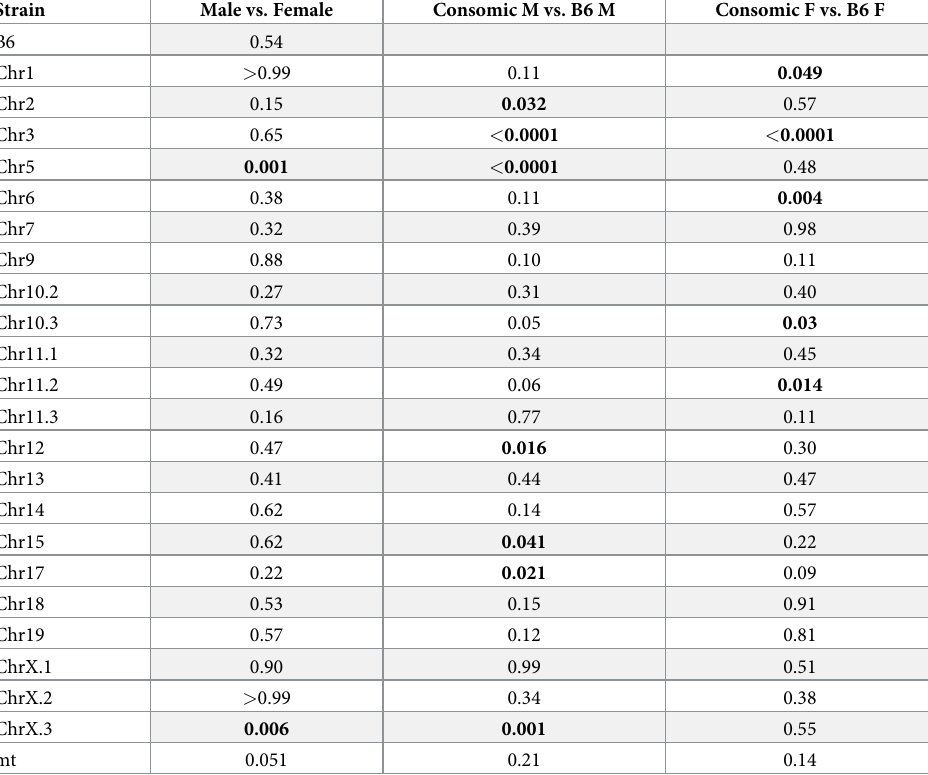
Table 2. Survival analysis of IAV-challenged consomic strains using sex-stratified data. Male and female consomic mice were challenged with IAV as described in Fig 3 . Significance of differences in survival assessed using the Mantel- Cox test and the P value are reported, with P < 0.05 shown in bold font. The following three comparisons were made: male vs. females of each consomic strain (Male vs. Female, column 1), consomic males vs. B6 males (Consomic M vs. B6 M, column 2), and consomic females vs. B6 females (Consomic F vs. B6 F, column 3). Strain Male vs. Female Consomic M vs. B6